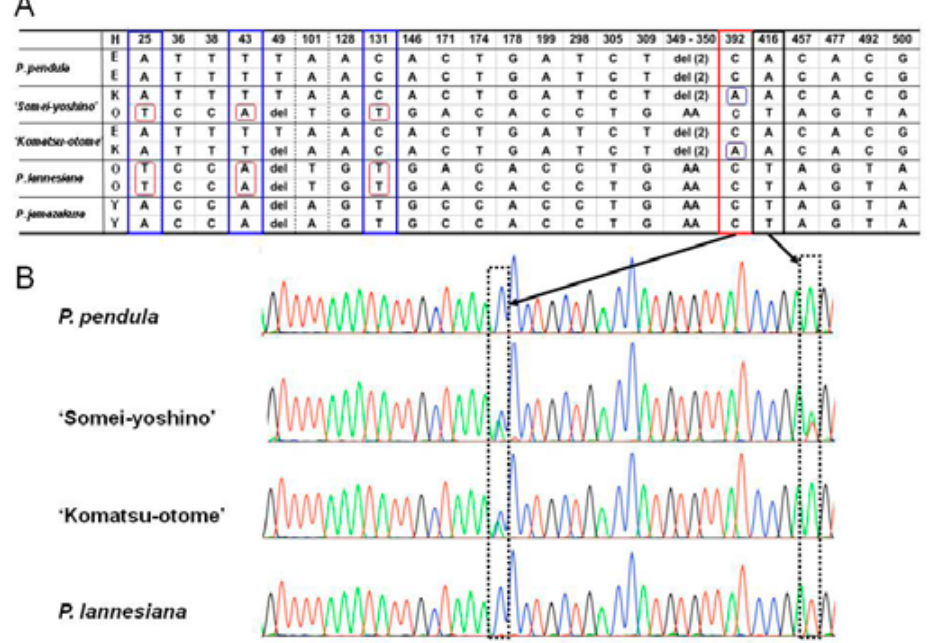
Fig. 5 - Haplotypes (H) of the intron 19 sequences in the PolA1 genes among ‘Somei-yoshino’ (KO), P. pendula (EE), ‘Komatsu-otome’ (KE), P. lannesiana (OO), and P. Jamasakura (YY) , A: polymorphic bases and their positions in two haplotypes are shown, B: Sequence charts were produced using 21ex3P primer and converted to the complementary charts using the 4Peak